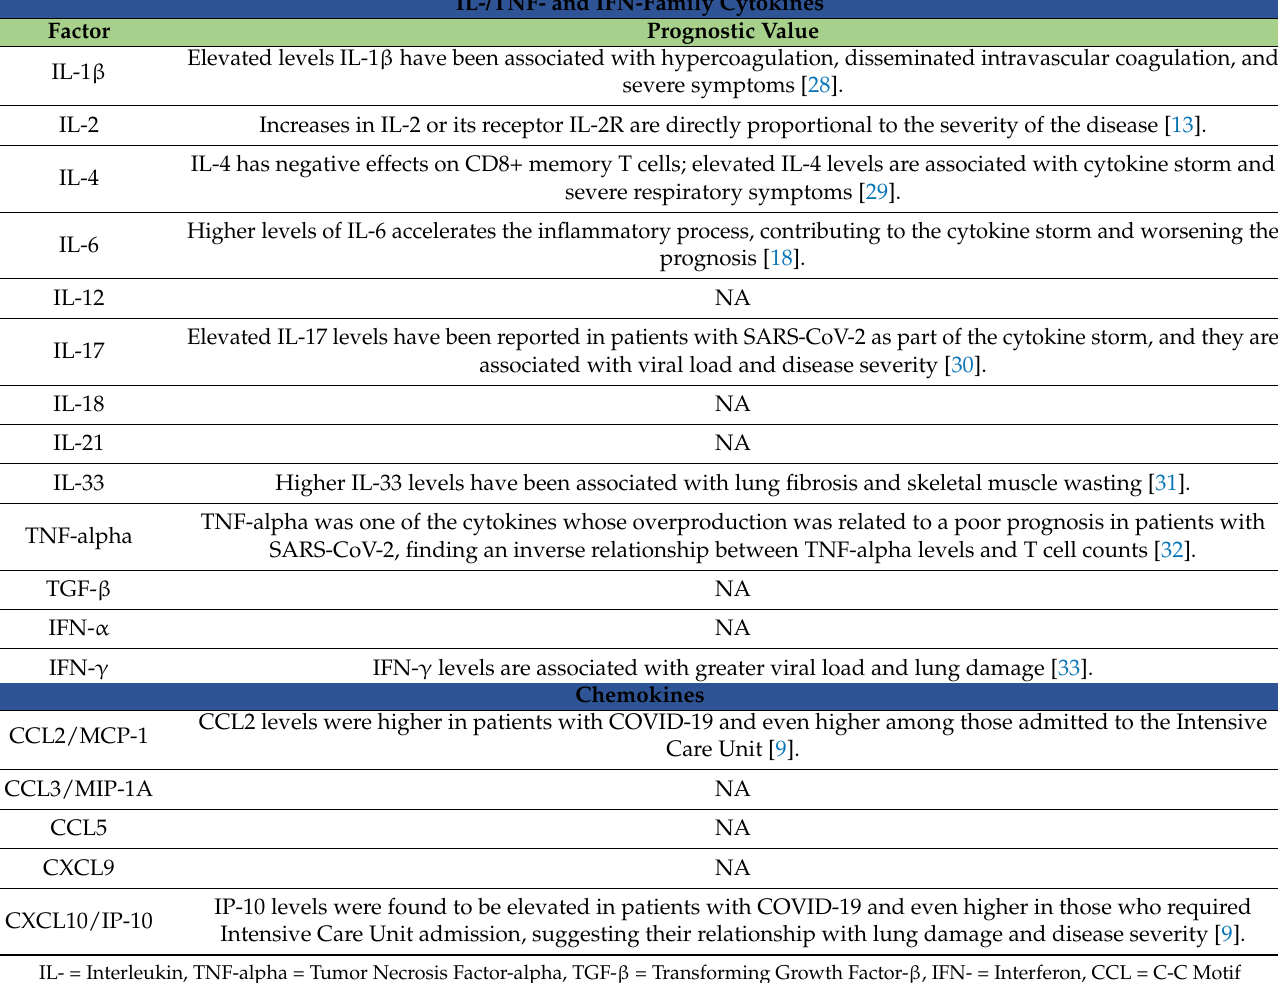
Table 1. Cytokines involved in COVID-19 and their prognostic